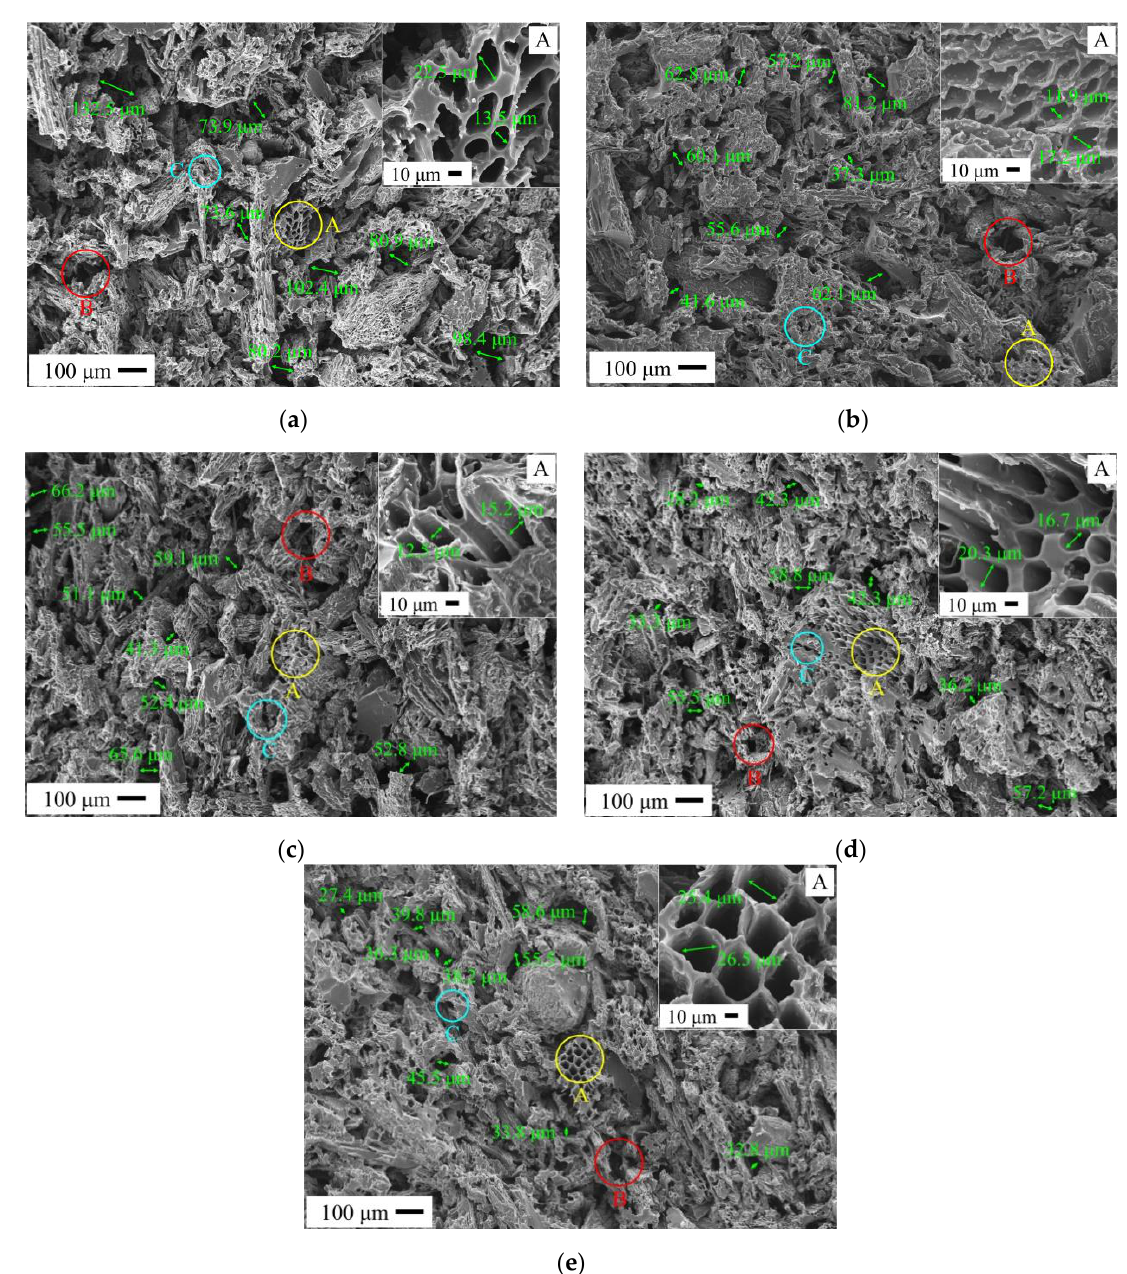
Figure 10 . SEM micrographs of C WCMs with different filling rate of wood powder under constant resin concentration of 30%: ( a ) filling rate = 33.3%; ( b ) filling rate = 37.5%; ( c ) filling rate = 41.6%; ( d ) filling rate = 50%; ( e ) filling rate = 58.3%.